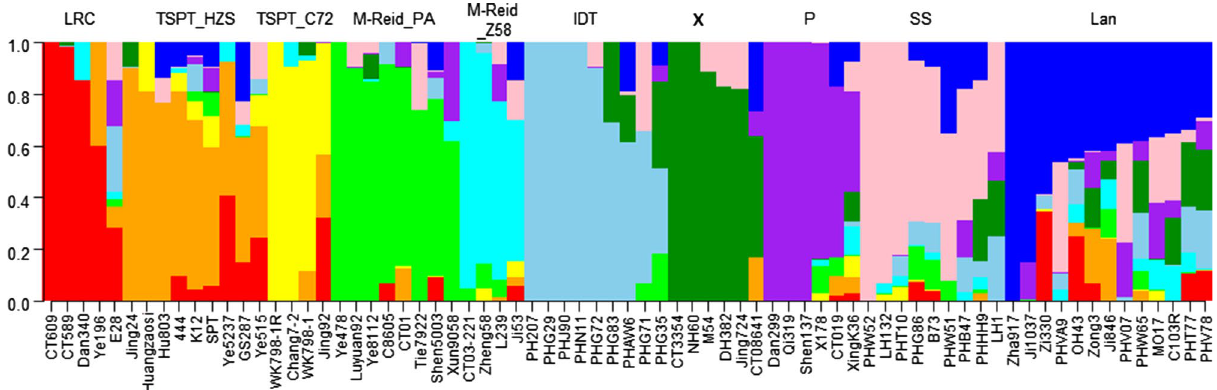
Figure 5. The subgroup assignment by ADMIXTURE for a set of indicator inbred lines when K =